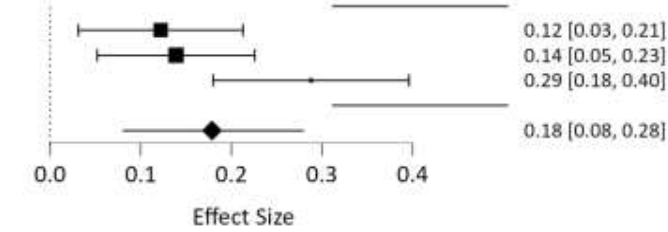
Figure 8. Forest plot of meta-analysis of Identified regulation and